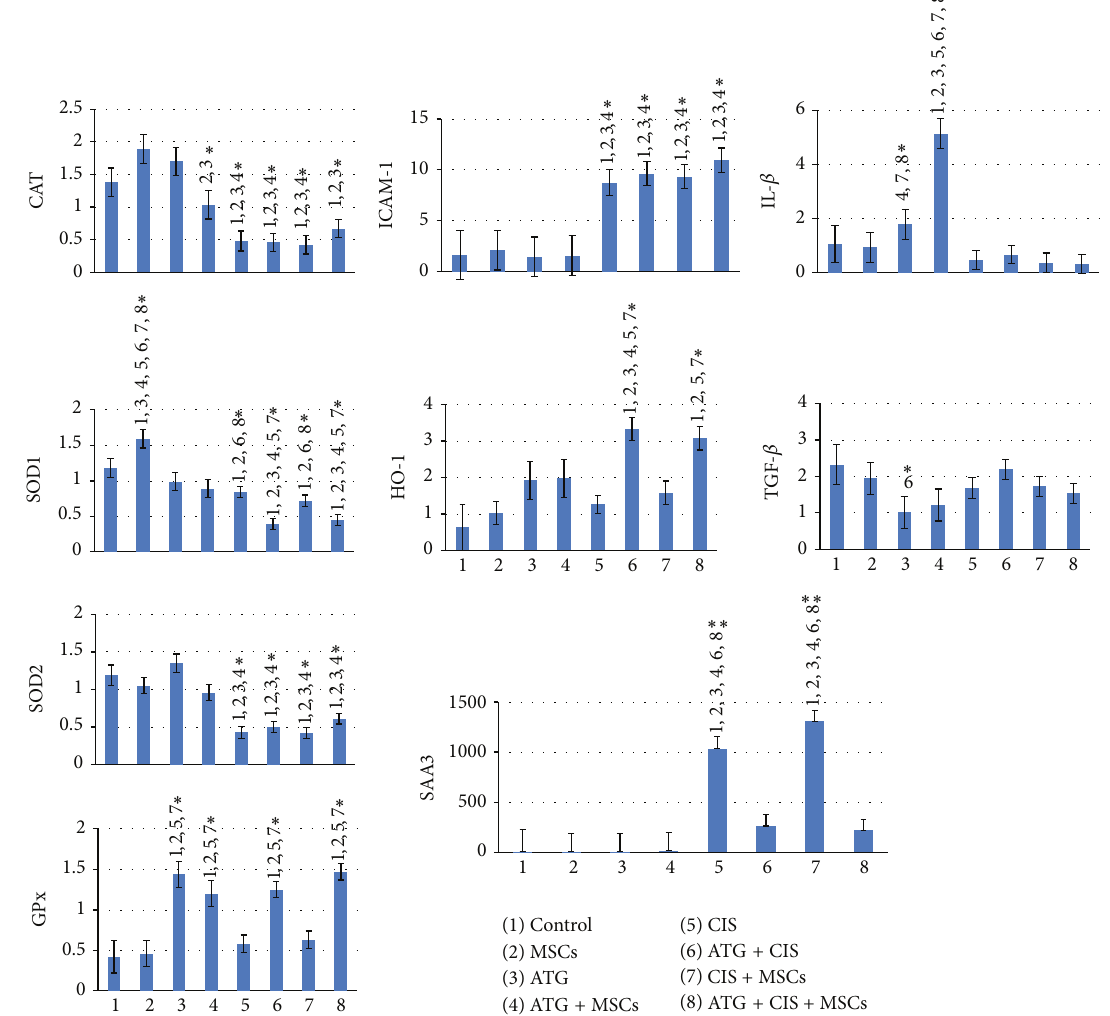
Figure 6: Gene expression of inflammatory and oxidative proteins in kidneys of 8–12-week-old male BALB/cOlaHsd mice after cisplatin- induced AKI treated with ATG and/or MSCs. Bars represent alterations in expression of cytokines, inflammatory, and oxidative proteins as measured by RT-PCR in kidney tissues of sacrificed mice. Results are expressed as mean ± SEM. ANOVA followed by Duncun multicomparison test: ∗ 𝑝 < 0.05 ; ∗∗ 𝑝 < 0.001 ; SAA3: serum amyloid A3, HO-1: heme oxygenase-1, GPx: glutathione peroxidase, CAT: catalase, SOD-1: superoxide dismutase-1, SOD-2: superoxide dismutase 2, IL-1 𝛽 : interleukin 1 𝛽 , TGF- 𝛽 : transforming growth factor 𝛽 , and ICAM-1: intercellular adhesion molecule